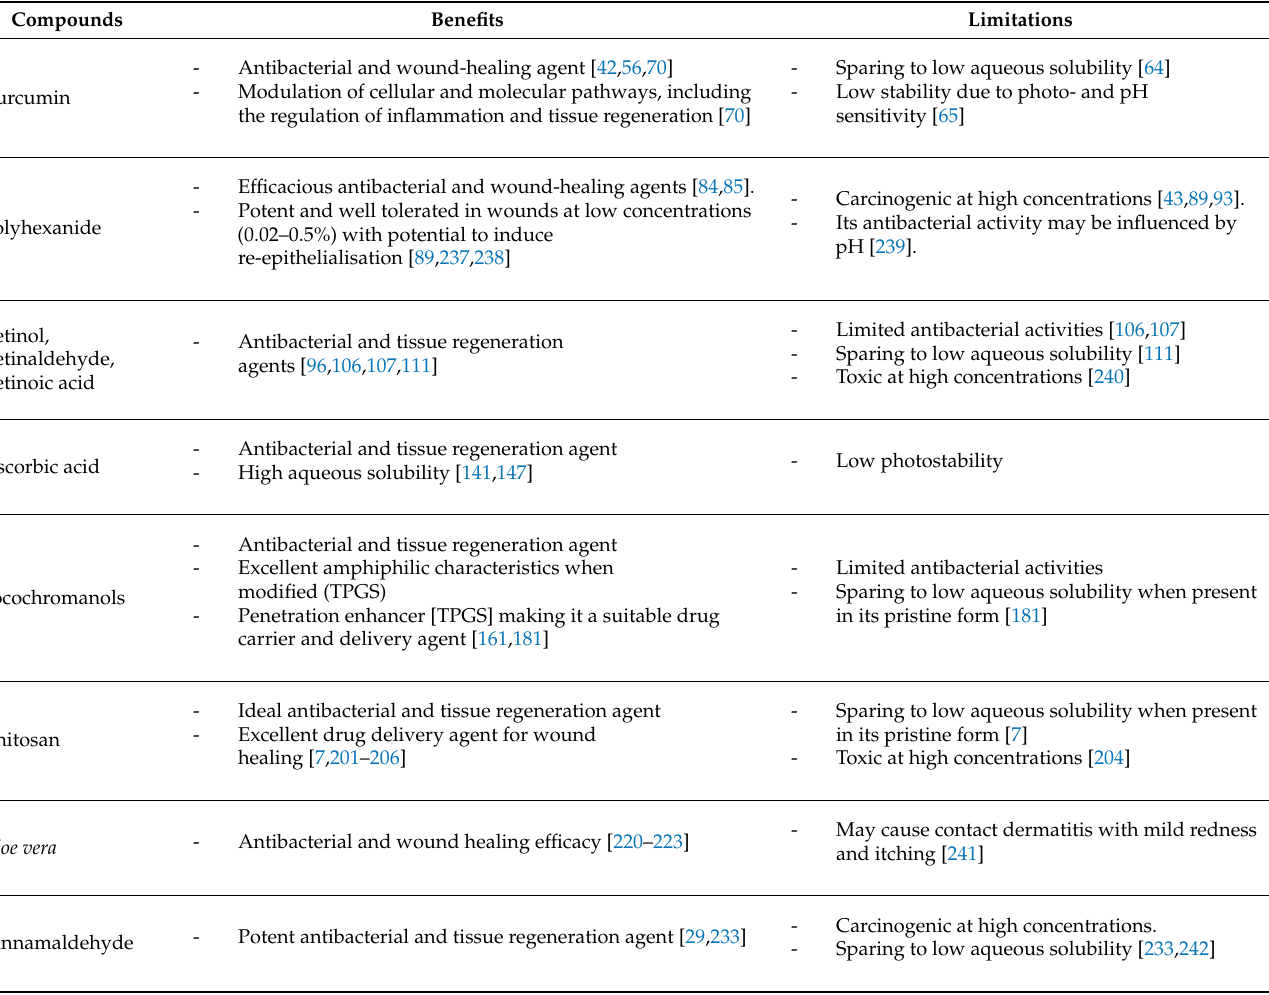
Table 3. The advantages, disadvantages, and challenges of each compound in treating chronic